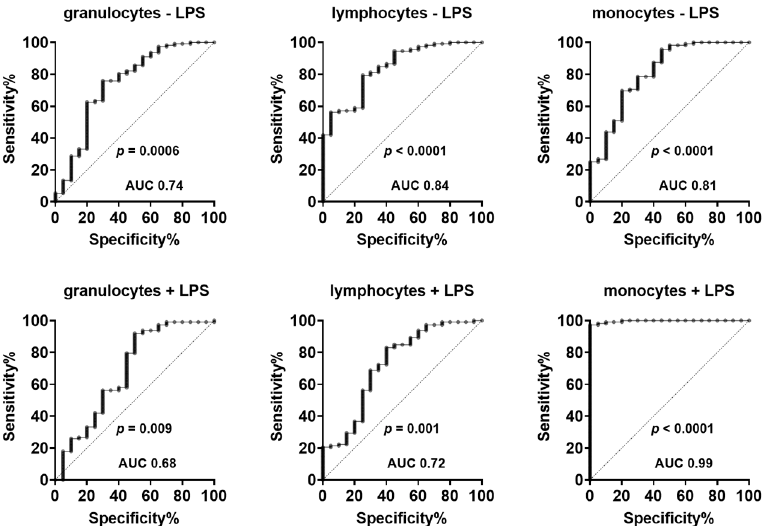
Figure 4. Receiver operating characteristic (ROC) curves describing the sensitivity and specificity of CD45 measurements in granulocytes, lymphocytes, and monocytes for the differentiation of healthy volunteers and COVID-19 patients. In the figures, the area under curve (AUC) and the significance levels are given.